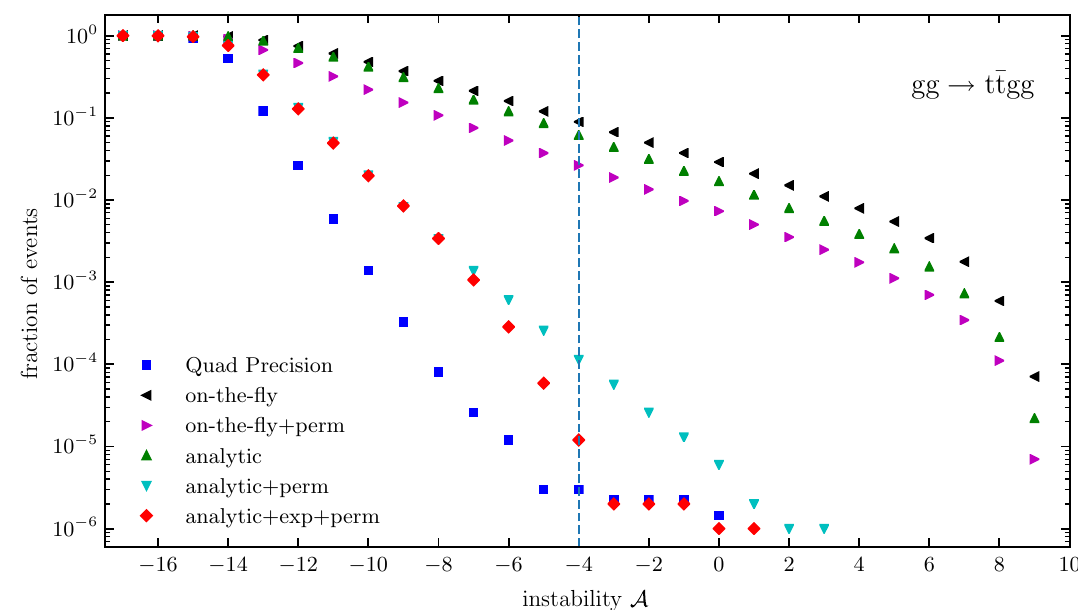
Fig. 14 Probability of finding events with instability A > A min as a function of A min in a sample of 10 6 gg → t ¯ tgg events. The stability of quad-precision benchmarks (blue) is compared to different variants of the OpenLoops2 algorithm in double precision. Unstable results with-